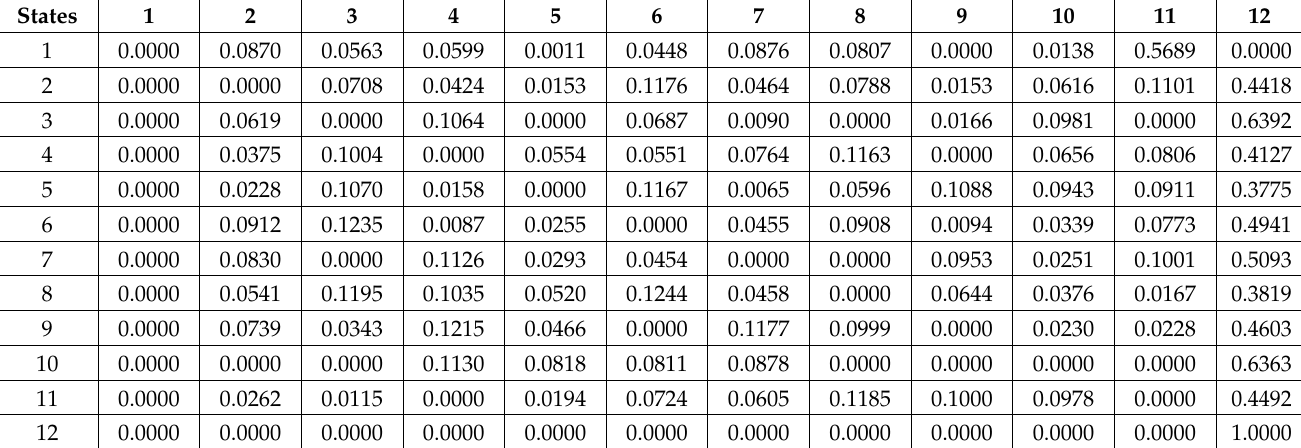
Table 2. Transition matrix P ij used in the numerical example. Source: Authors’ own elaboration. States